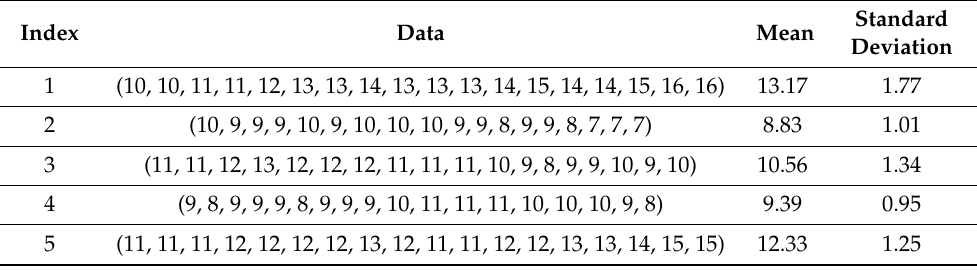
Table 3. Example original